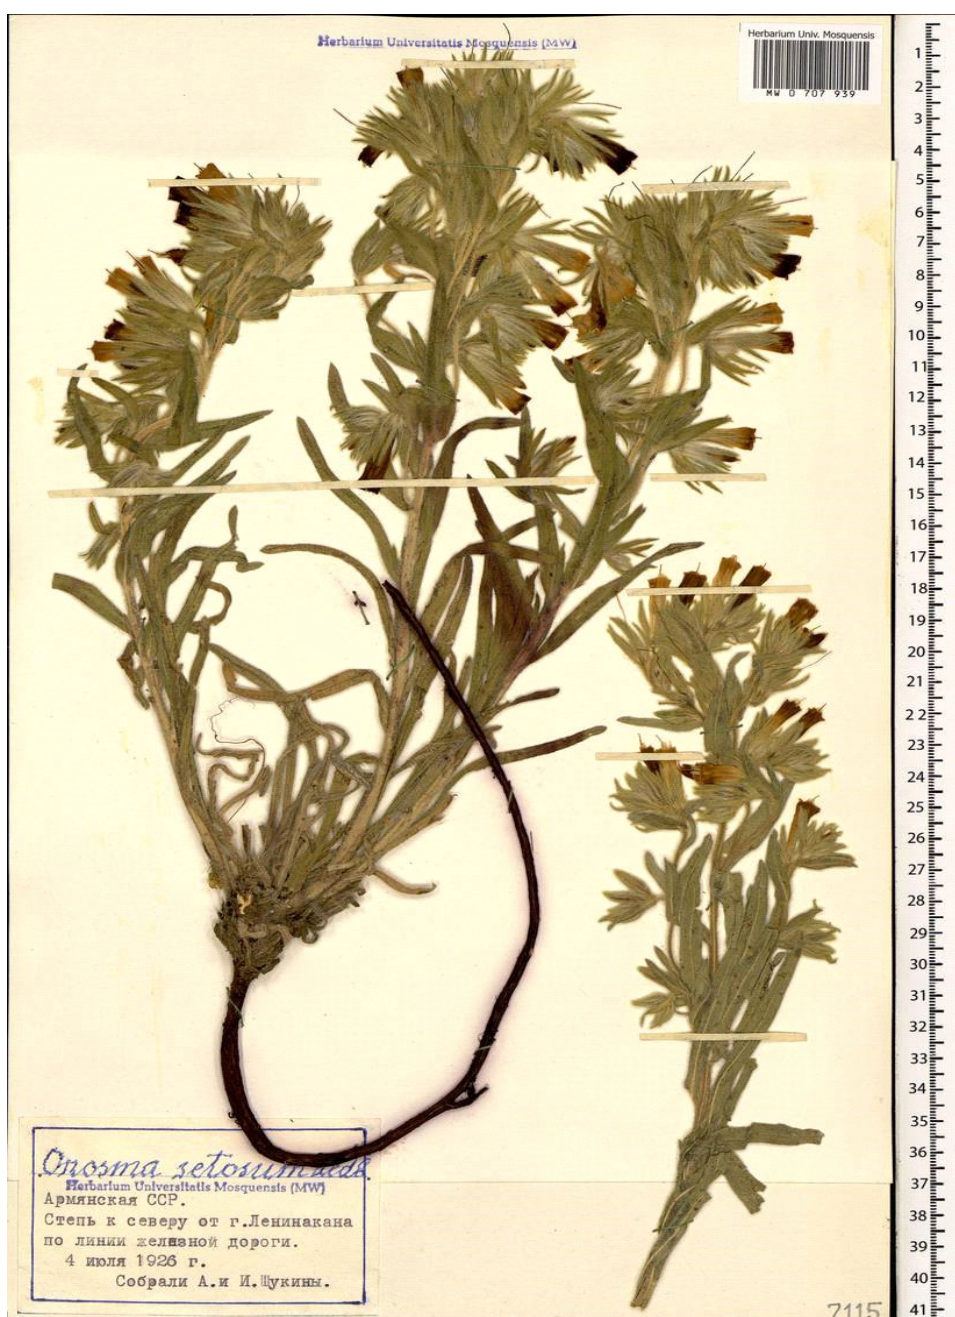
Figure 1. Onosma setosa Ledeb. collected from Central Asia.